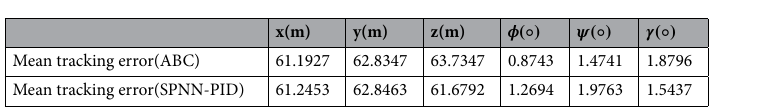
Table 4. The comparison for control statistical indicators of task